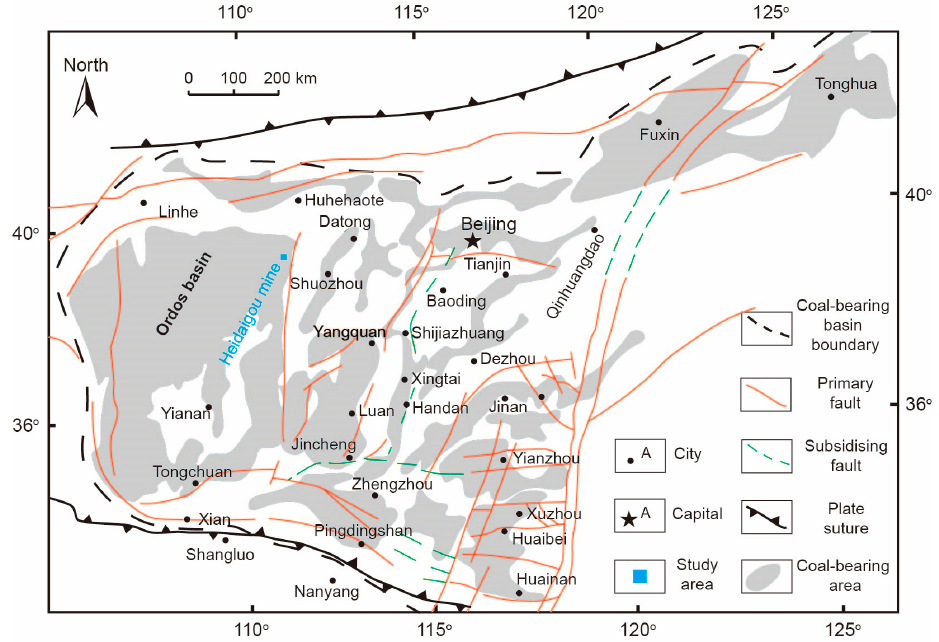
Figure 1. Coal-bearing basins in the Northern China plate and the Heidaigou mine location.